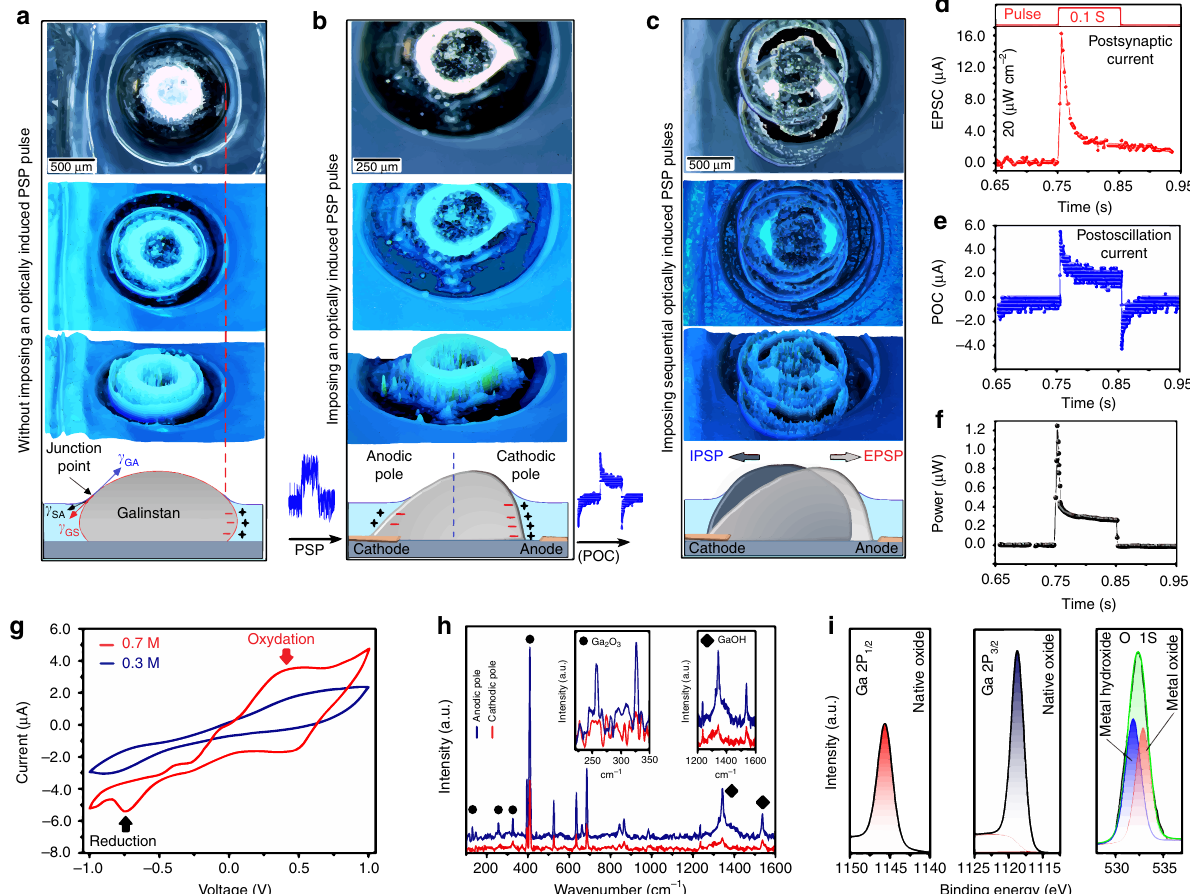
Fig. 4 The observation and characterisation of oscillation behaviour of galinstan droplet. a From top to down, respectively, demonstrates the actual top view, the optical contrast image, the generated 3D model and schematic interpretation of a galinstan droplet inside NaOH bath, without imposing applied potential, b when a singular postsynaptic pulse of 50 ms laser pulse (20 μ W cm − 2 ) was transmitted to galinstan actuator, and c when the consecutive laser pulses are used to oscillate the galinstan actuator. d Shows the EPSC of synaptic device stimulated by 0.1 s pulsed laser (20 μ W cm − 2 ), and e the corresponding POC of galinstan actuator, and f corresponding power consumption for oscillation of galinstan actuator. g The C-V of HGDE device. h The results of in-situ Raman studies of galinstan droplet. Inset shows the peaks of Ga 2 O 3 and GaOH. i The core level XPS spectra of Ga2P, and O1S of surface oxide of galinstan